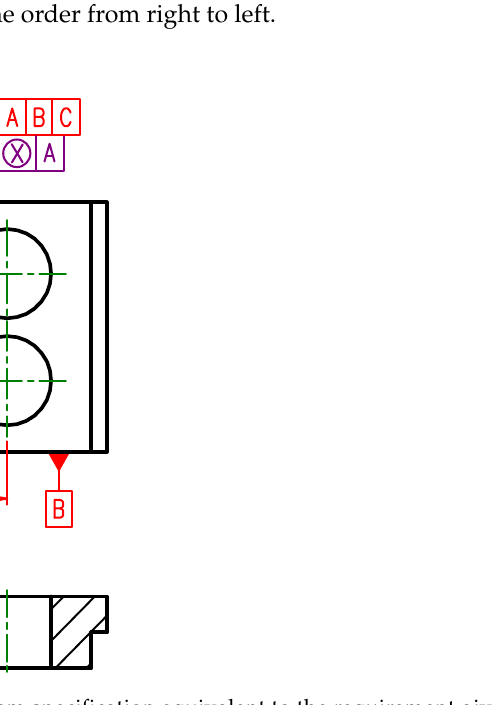
Figure 14. The ISO GPS system specification equivalent to the requirement given in Figure 13a.